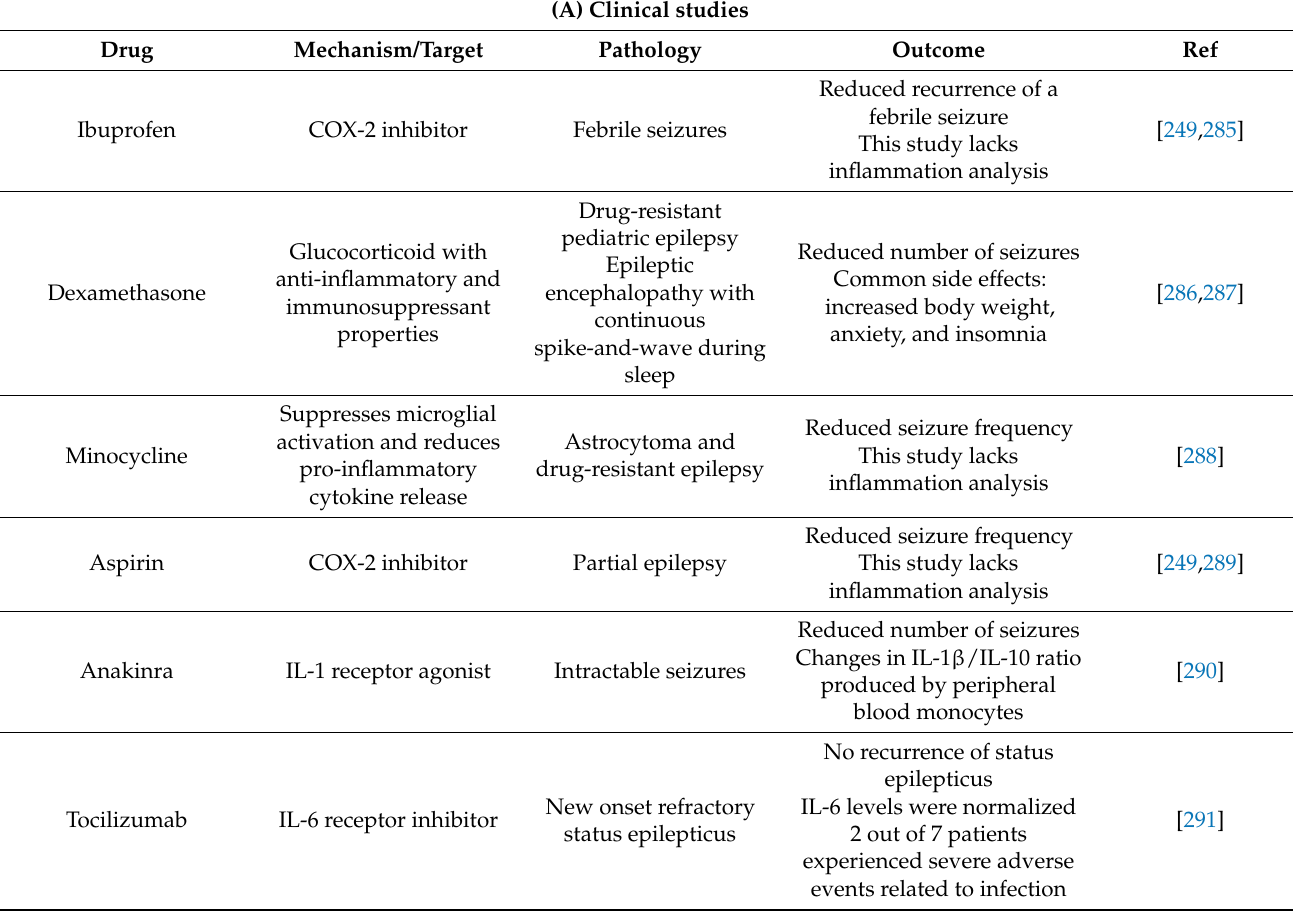
Table 1. Drugs with anti-inflammatory effects used in clinical and pre-clinical studies to treat epilepsy. (A) Clinical studies Drug